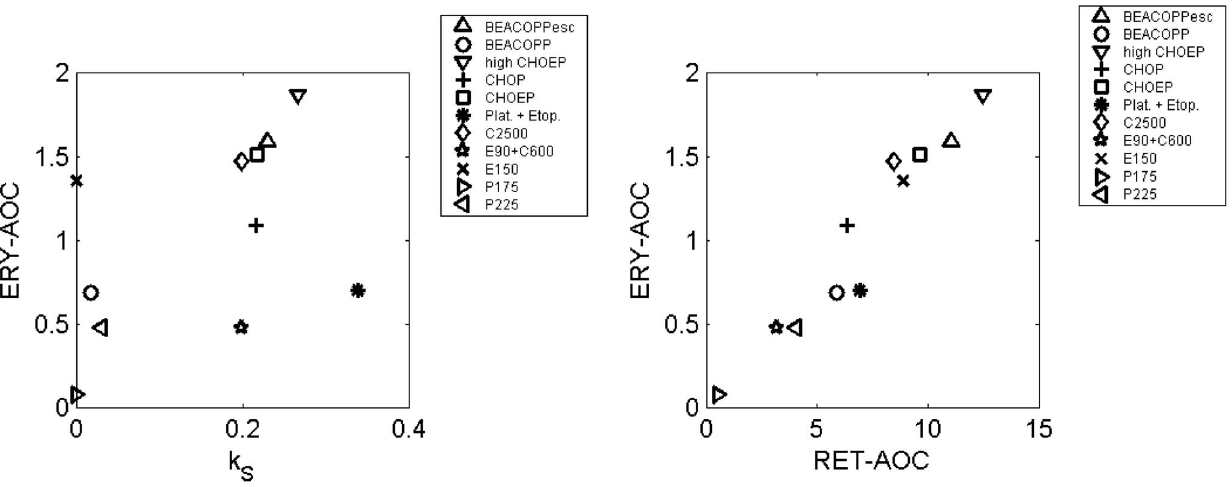
Figure 9. Comparison of toxic effects between different chemotherapies. We present the relations between stem cell toxicities and resulting AOC of reticulocytes and erythrocytes for a single therapy cycle.